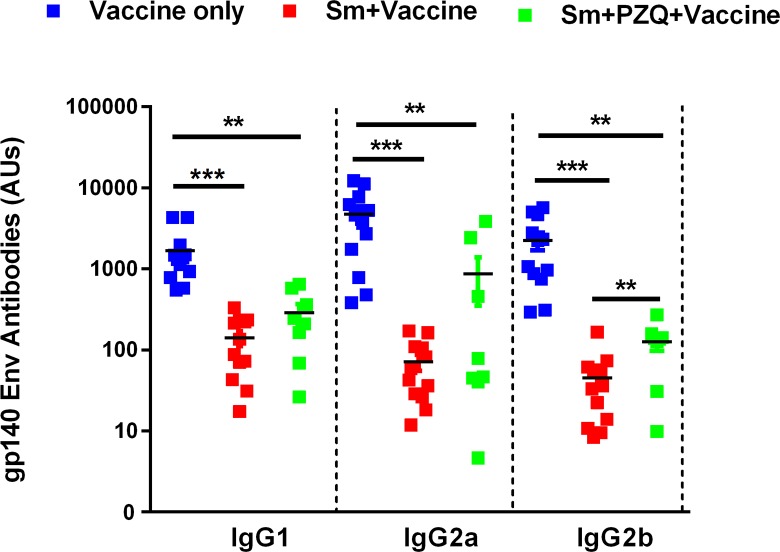
Schistosoma mansoni infection significantly reduces HIV-1 Env gp140-specific antibodies.Blood for preparation of serum was collected two weeks after the last vaccination. HIV-1 Env gp140-specific IgG1, IgG2a and IgG2b antibodies were analysed by ELISA. Values are plotted and expressed as mean antibody units (AUs) ± SEM for the 8–12 animals in each group. Statistical differences between the groups were calculated by unpaired t-test (two-tailed). (*: p<0.05; **: p<0.01; ***: p<0.001).